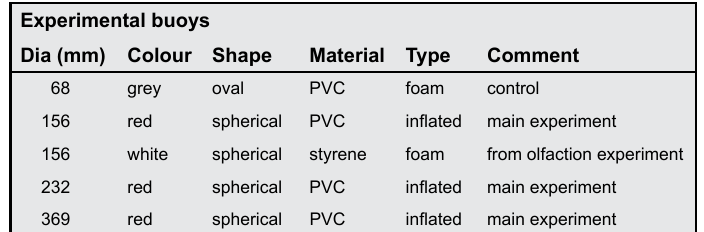
Table 1 . Size and colour of the baited experimental buoys in the field trial.